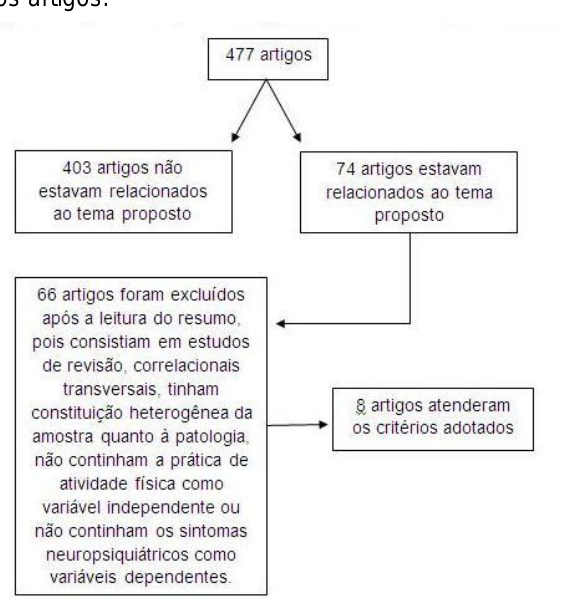
Figura 1. Etapas de seleção dos artigos incluídos